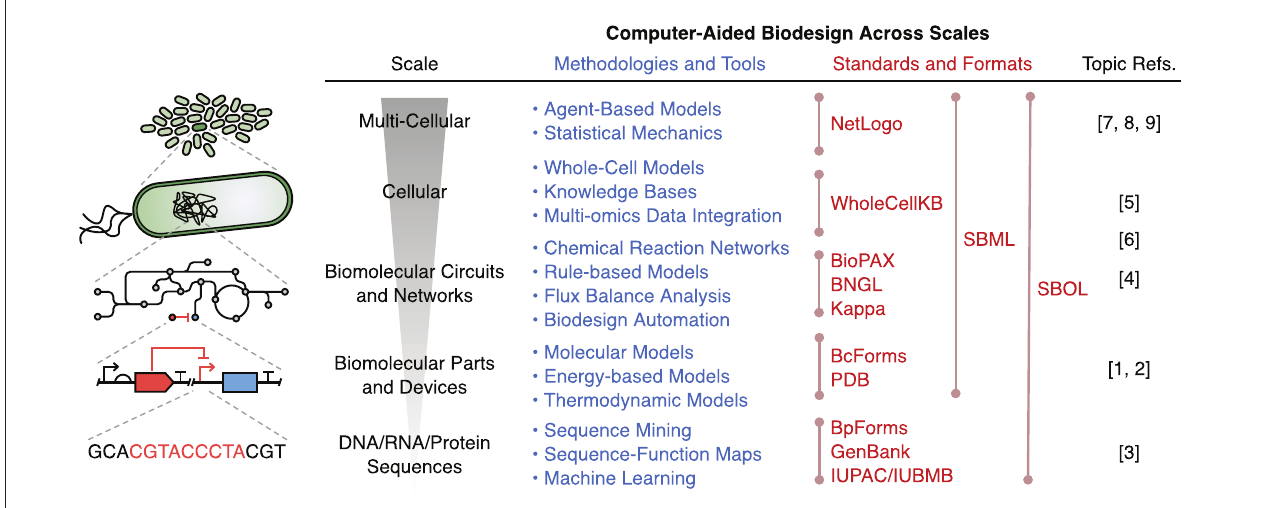
FIGURE 1 | Overview of computer-aided biodesign methodologies, tools, and standards used across scales. Although each methodology/tool has been placed at the specific scale it is commonly used, it should be noted that many can be applied across scales. Lines in the “Standards and Formats” section denote the range of scales over which the standard/format can be used. BioPAX, Biological Pathway Exchange; BNGL, BioNetGen Language; SBML, Systems Biology Markup Language; SBOL, Synthetic Biology Open Language; PDB, Protein Data